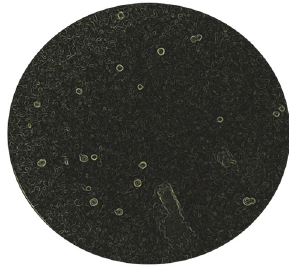
Figure 1: India ink preparation demonstrating numerous budding yeast cells surrounded by capsular halo consistent with the identifi- cation of Cryptococcus species. X100.